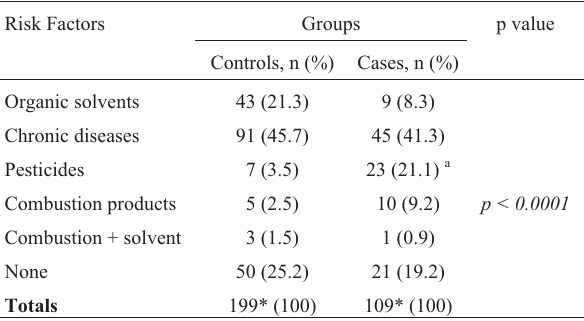
Table1 -Exposuretooccupationally-borneandotherriskfactorsbetween case and control